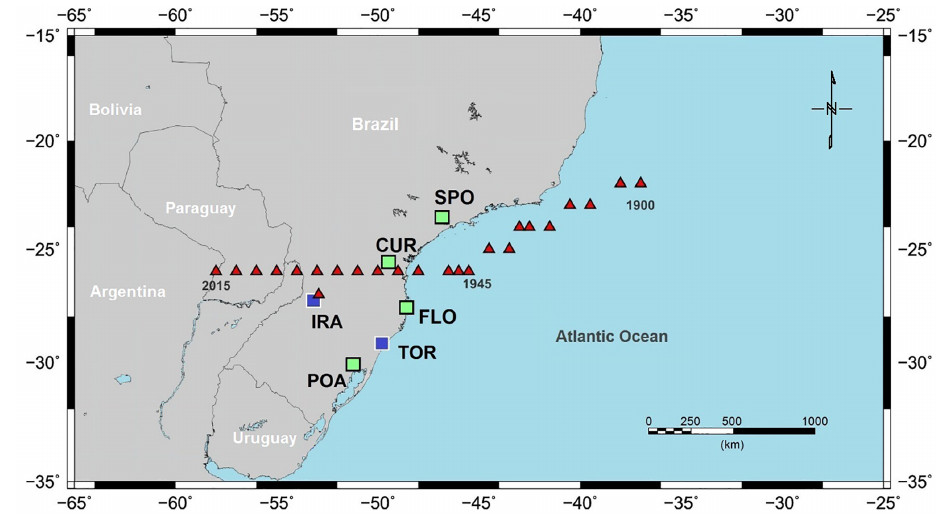
Figure 1. Map of southern South America indicating the positions of the center of the SAMA between 1900 and 2015 (red triangles), locations of the weather stations used by Frigo et al. (2013) (green squares) and the weather stations used in this work (blue squares).